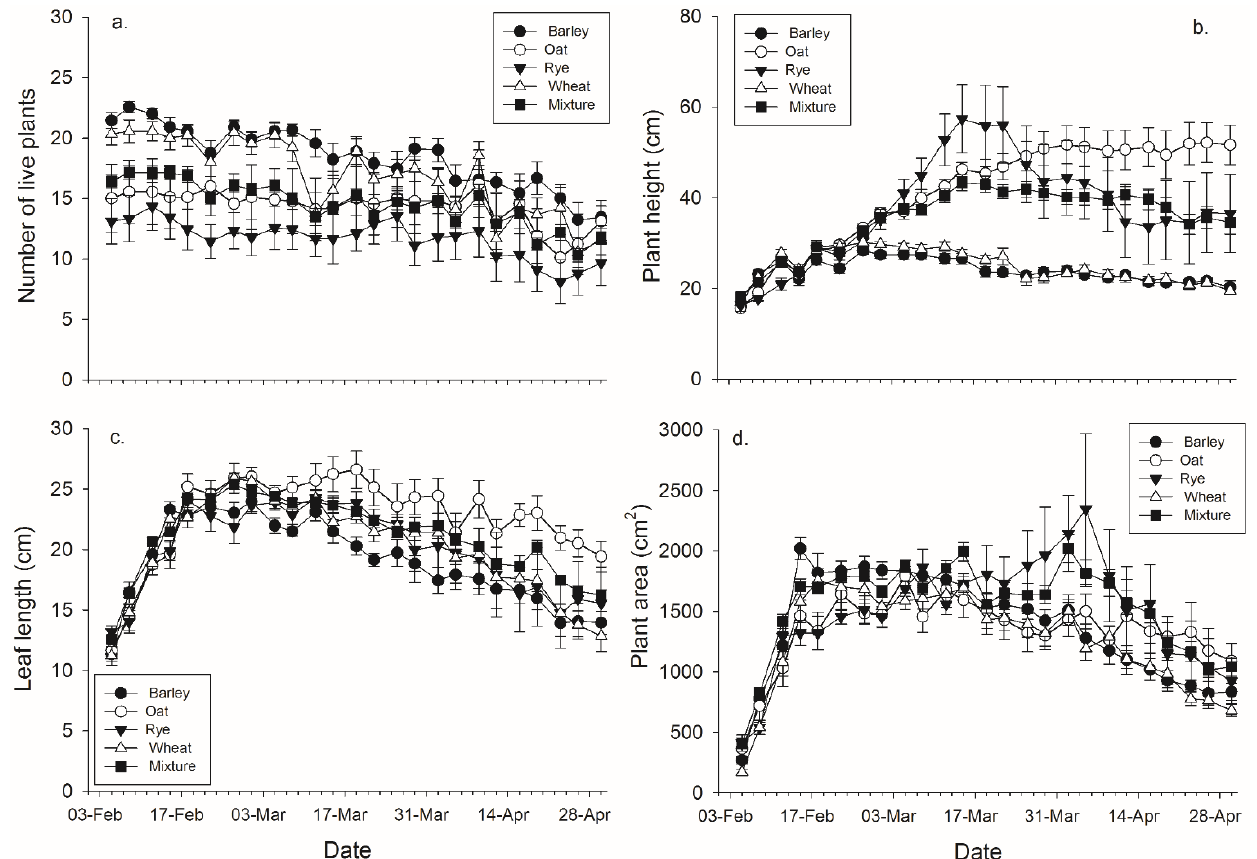
Figure 2. Mean (± SEM) ( a ) number of plants surviving within a pot; ( b ) height of the tallest plant per pot; ( c ) length of the leaves per pot, and ( d ) plant area in pots with each plant species and pots with